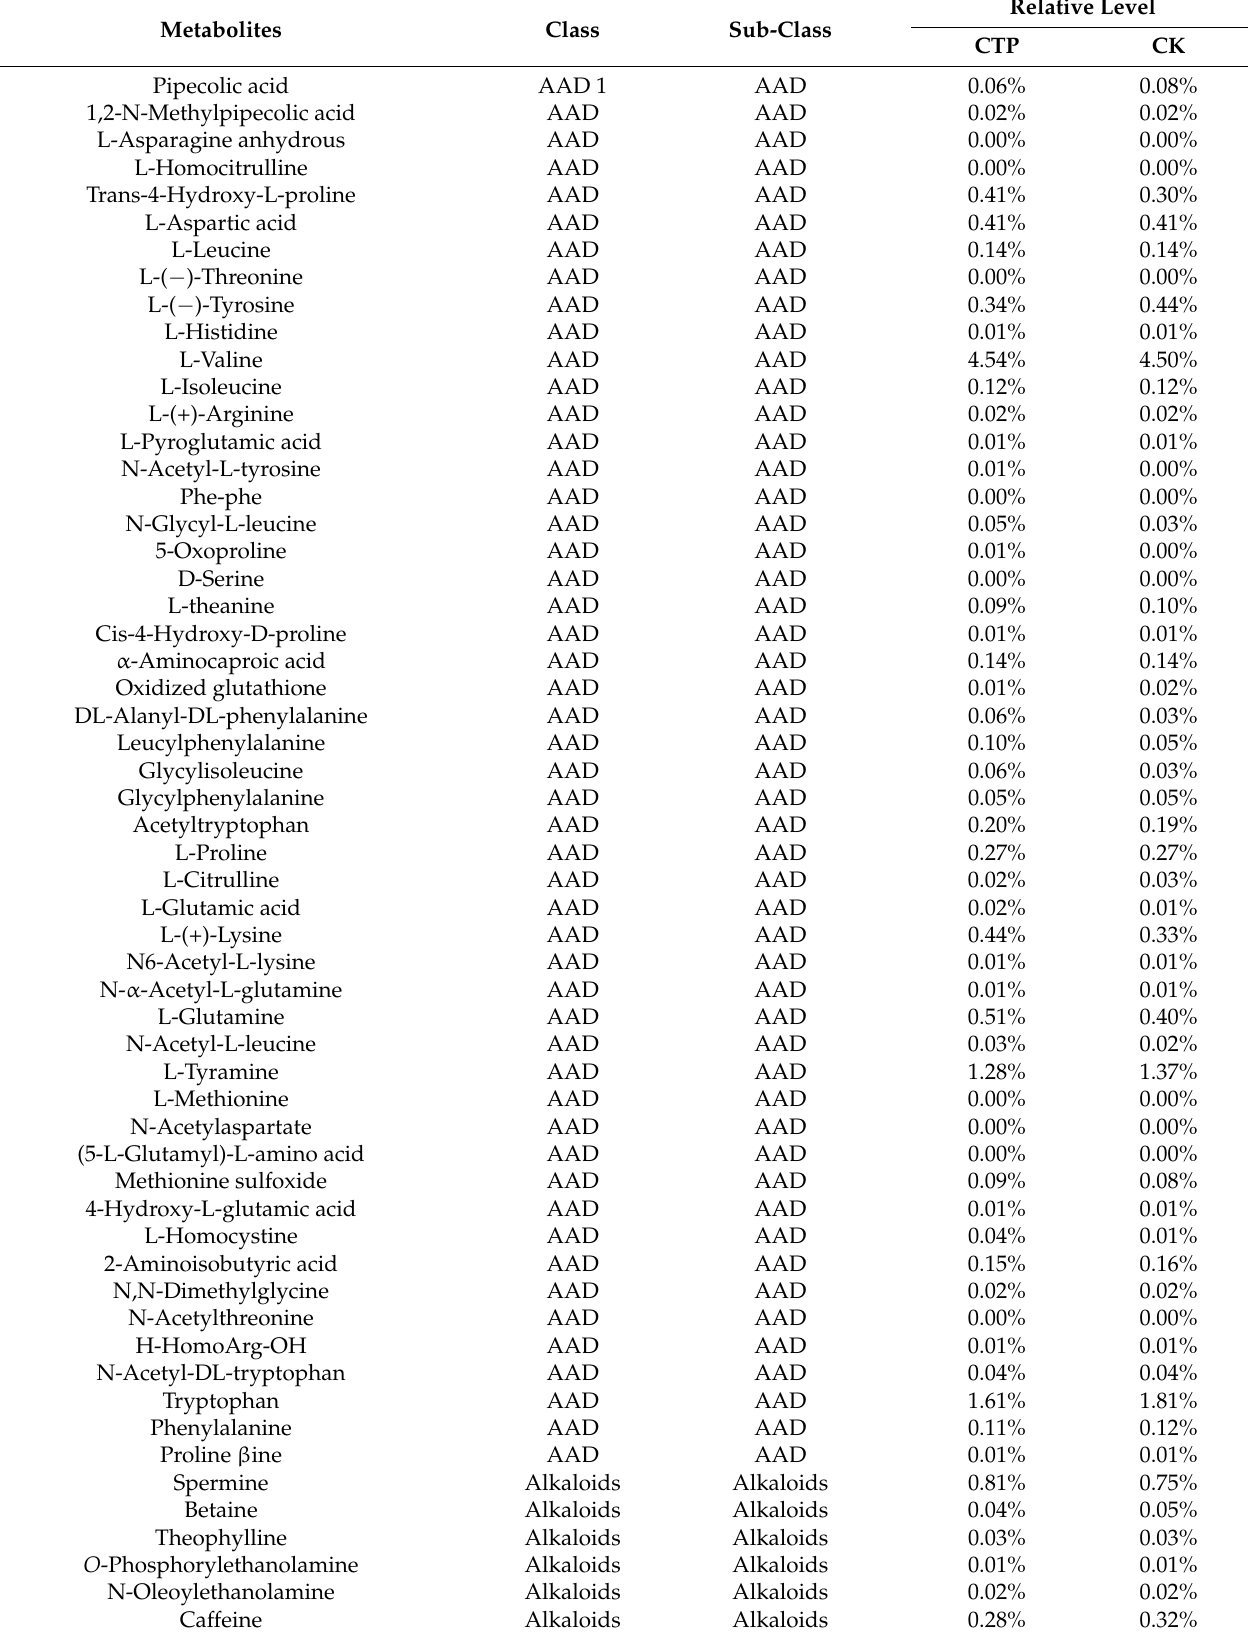
Table 1. The relative levels of metabolites in CTP and